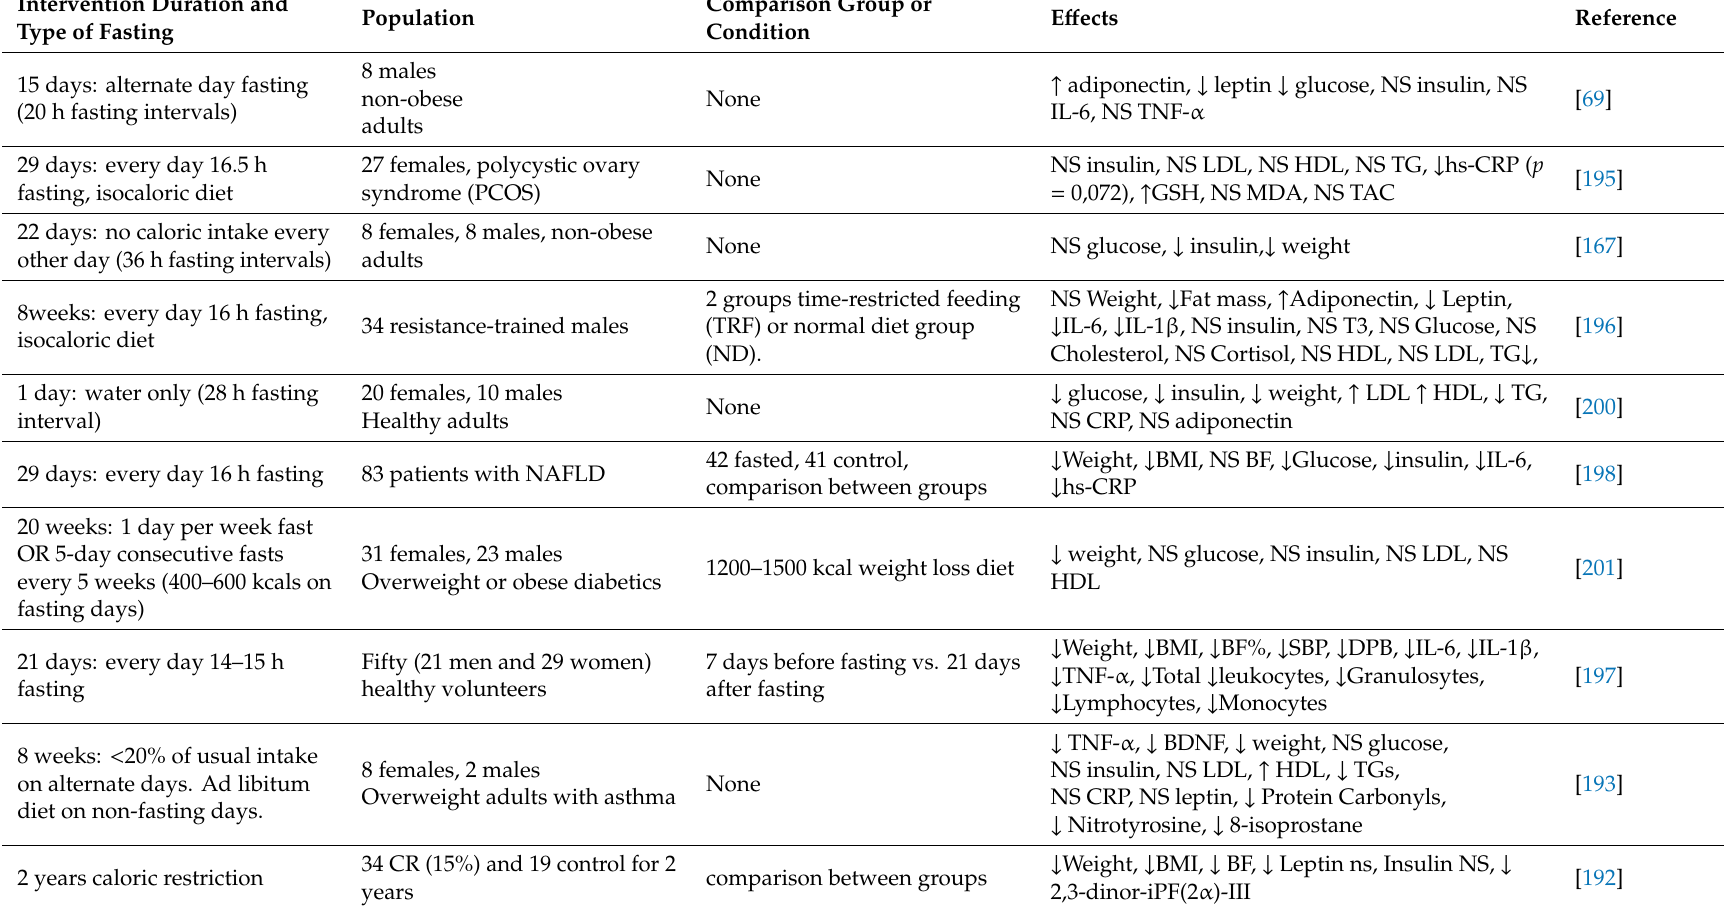
Table 2. Recent reports concerning fasting and